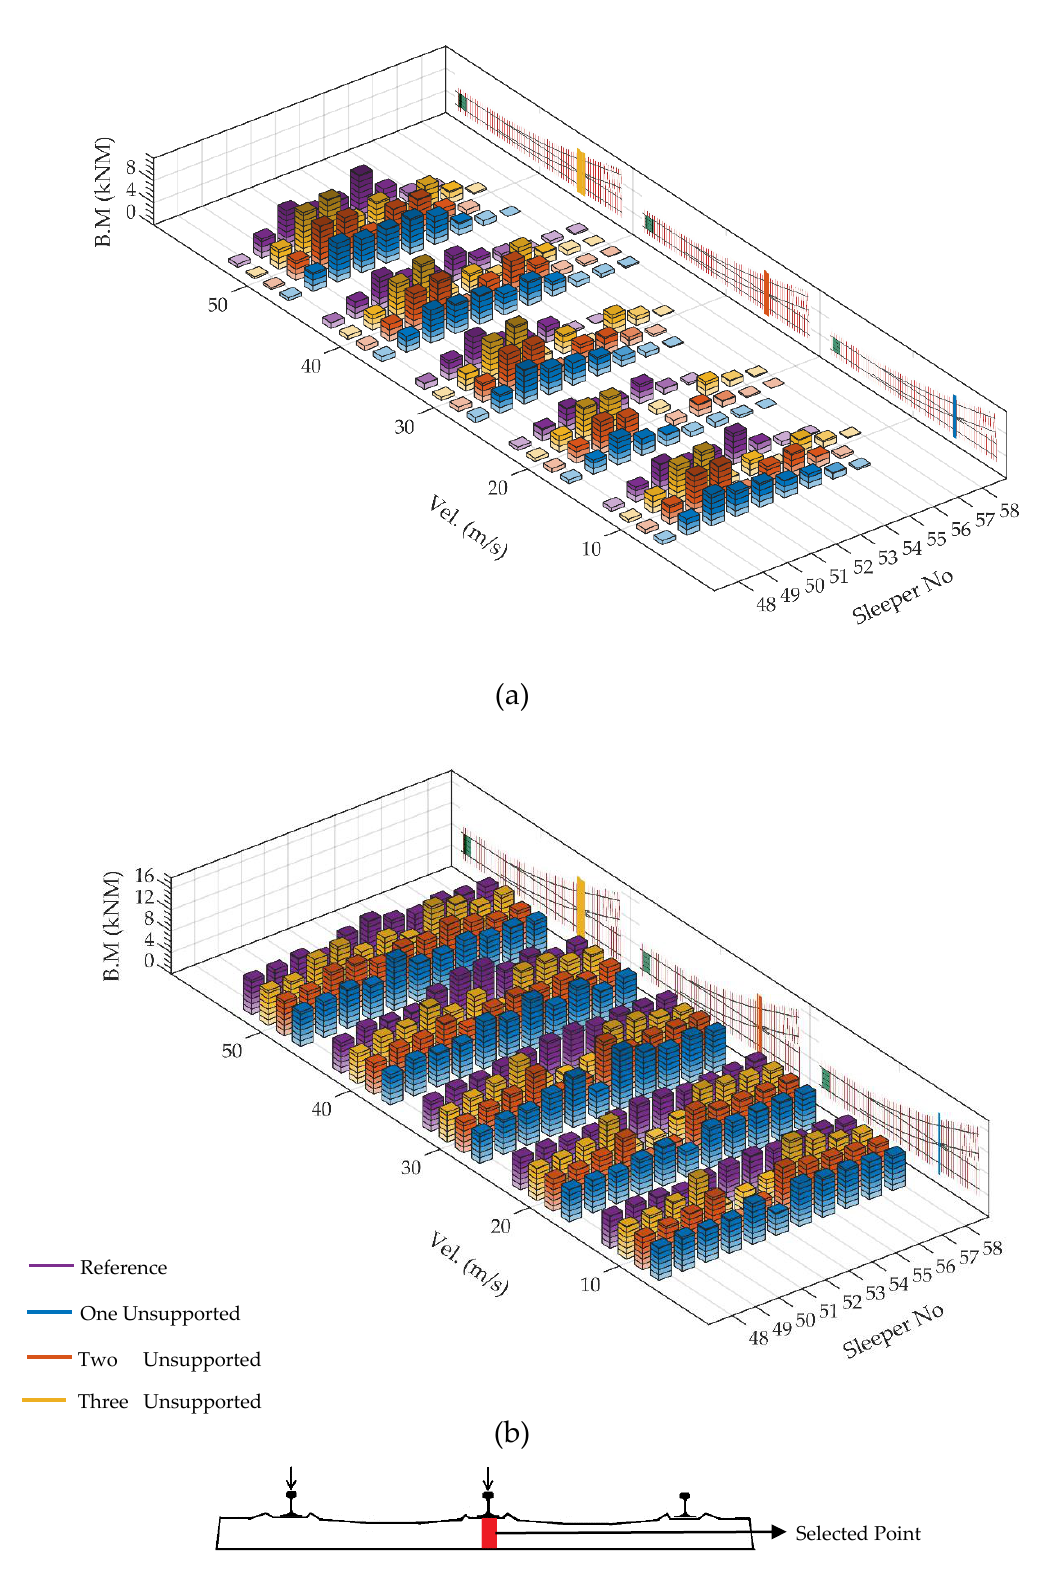
Figure 25. The distribution of positive bending moments over the bearers when unsupported bearers exist under crossing nose: ( a ) at particular time when the front wheel is on the bearer with number 53; ( b ) when maximum occurs at each bearer.